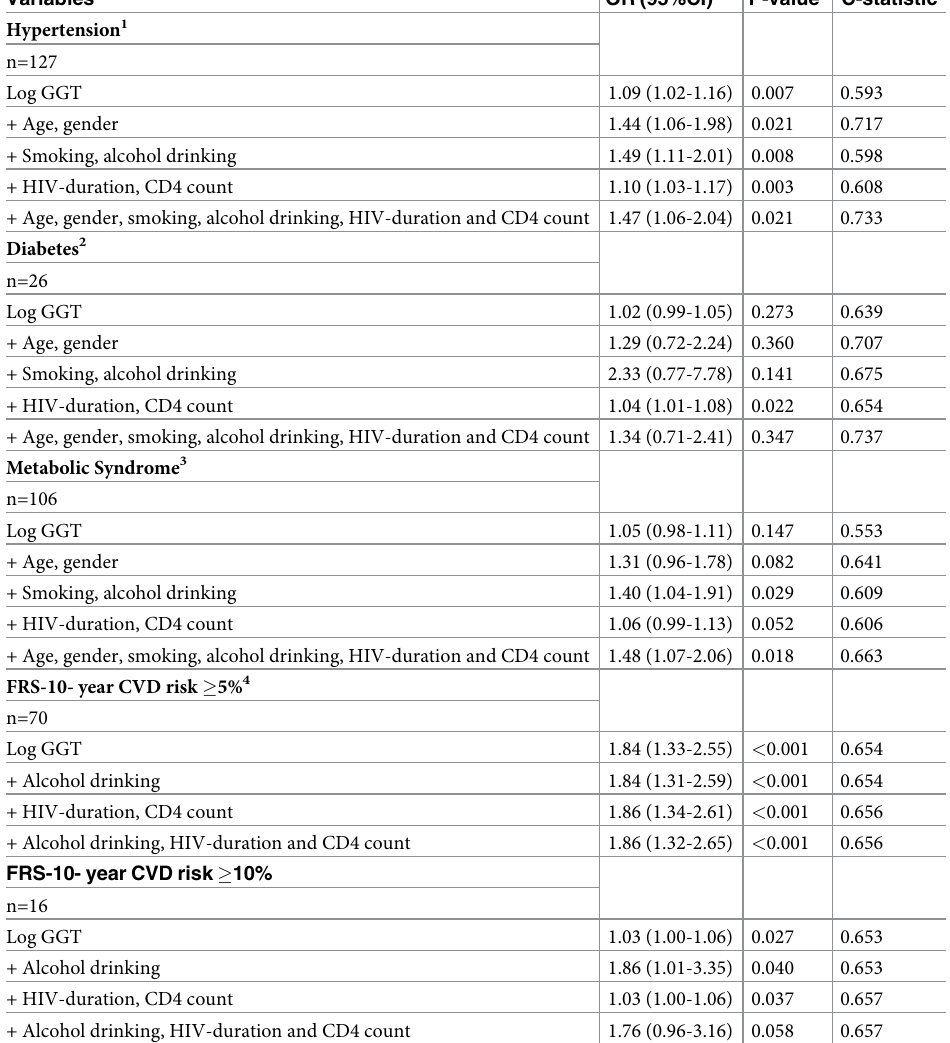
Odds ratios (OR) and 95% confidence interval (CI) from logistic regression models adjusted for age, gender, smoking, alcohol drinking, HIV-diagnosed duration and CD4 count 1 Hypertension, SBP � 140mmHg and/or DBP � 90mmHg and/or history of hypertension 2 Diabetes, FPG � 7mmol/L and/or 2h-PG � 11.1mmol/L and/or history of diabetes 3 MS (JIS), metabolic syndrome based on Joint Interim Statement (2009) criteria